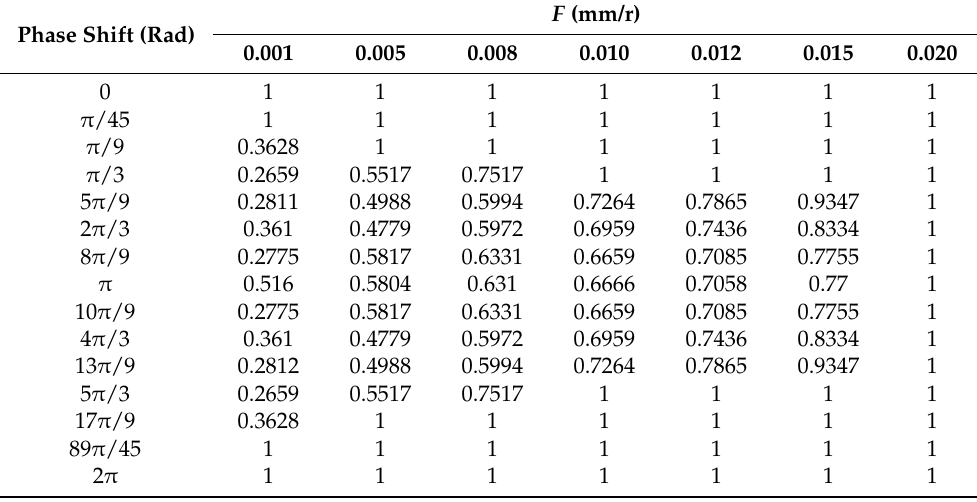
Table 5. Duty cycle values (2 A = 20 µ